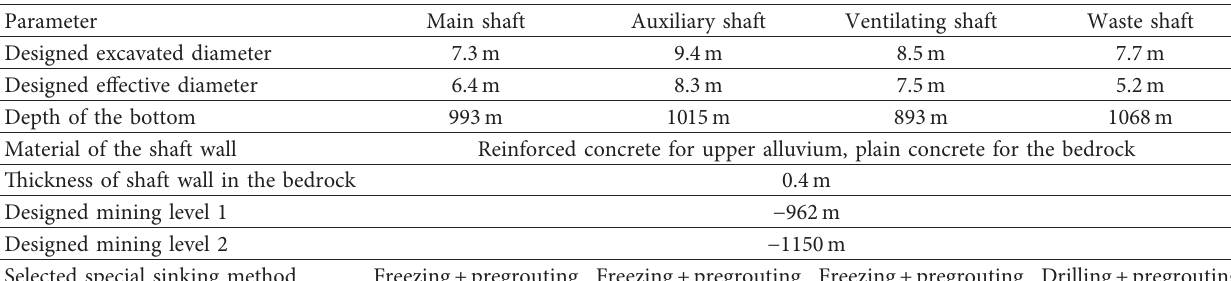
Table 1: Designed parameters of